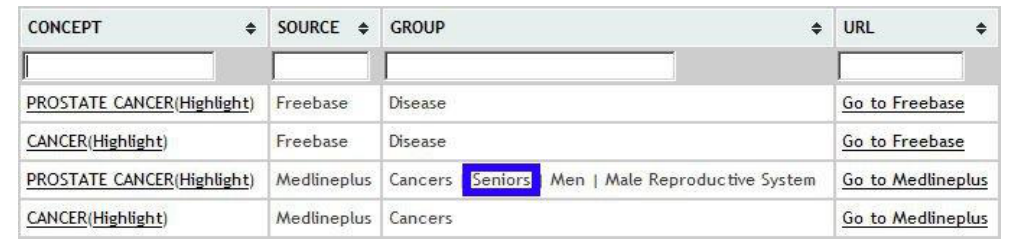
Figure 9. Relevant entity recognition from MedlinePlus for seniors.